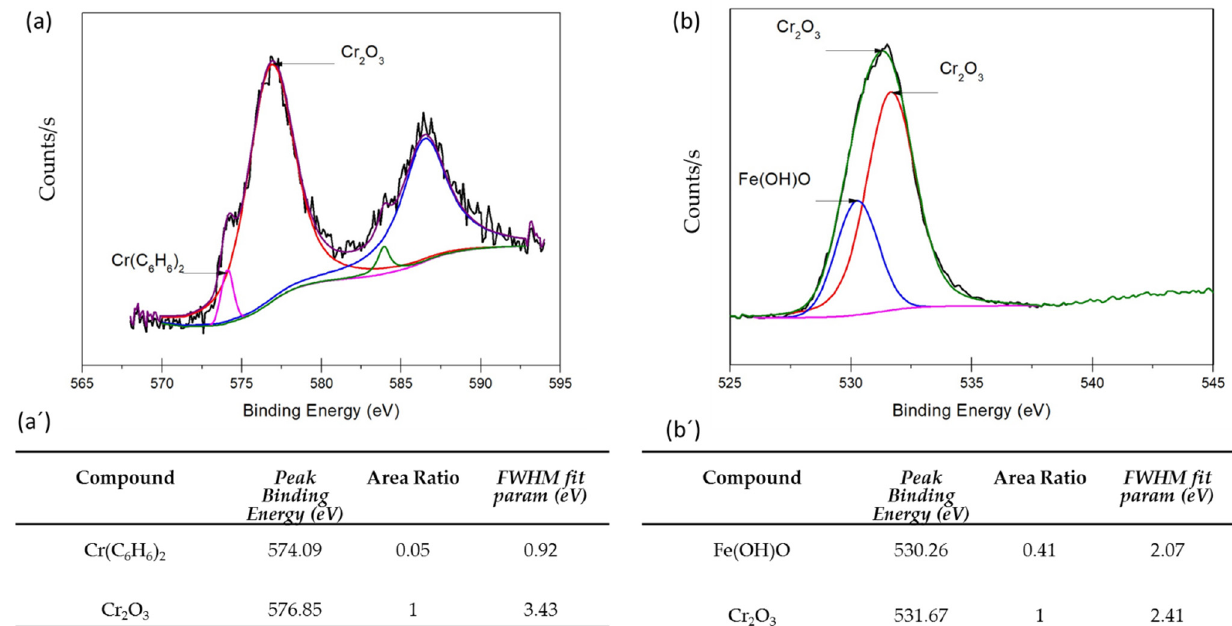
Figure 9. X-ray photoelectron spectra for AM350NA–50 min–70 °C: ( a ) Cr 2p, ( b ) O 1s. Parameters obtained: peak binding energy and FWHM fit param ( a’ ) Cr 2p, ( b’ ) O 1s.